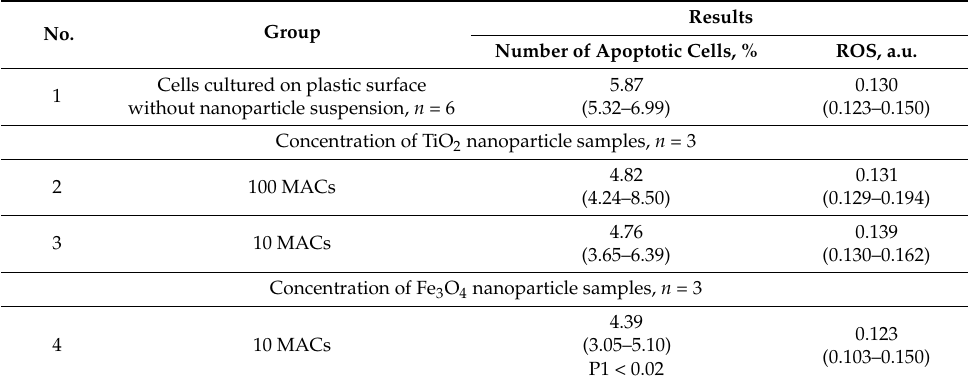
Table 7. Proportions of apoptotic Jurkat T cells and intracellular levels of ROS after 24 h of culture with nanoparticle suspensions, Me (Q 1 –Q 3 ).